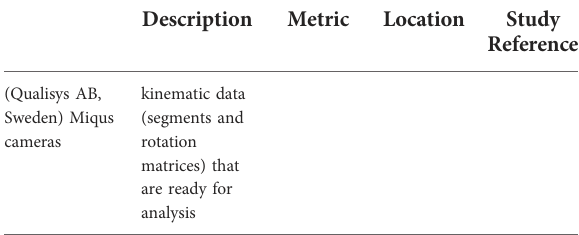
TABLE 4 Identi fi ed commercially available technology with related corresponding information and study reference in which it was